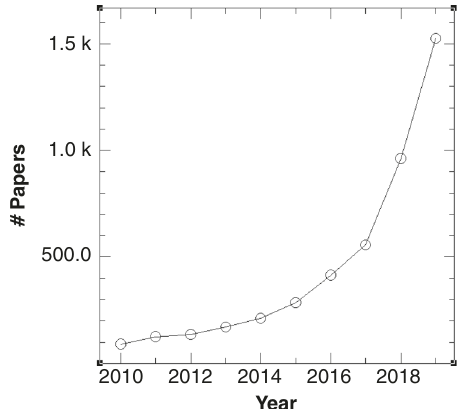
Fig. 1 Publications each year from a web of science search with topics of machine learning and either chemistry or materials, July 20, 2020. The average number of citations per article is 12. This updates Fig. 1 of ref. 30